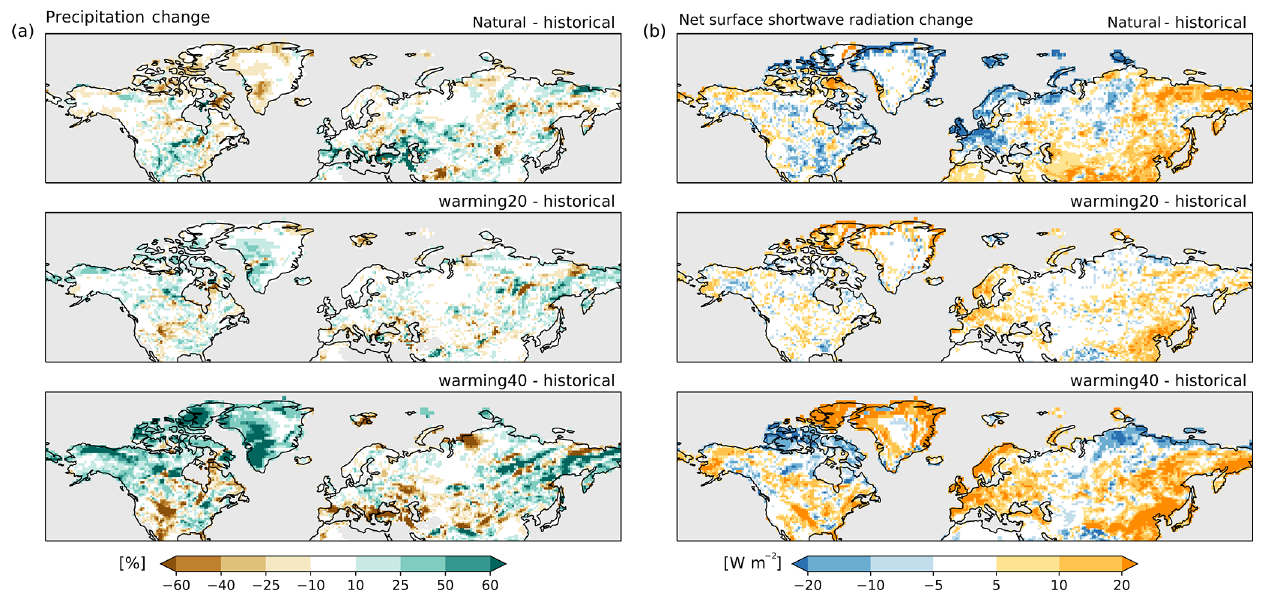
Figure 6. (a) Changes in precipitation (%) and (b) net shortwave radiation at the surface (Wm − 2 ). Changes are averaged over 13 to 27 July 2018 and are given as anomalies from the historical simulation. Land areas with less than 0.1mmd − 1 precipitation in the historical simulation are masked out in (a)